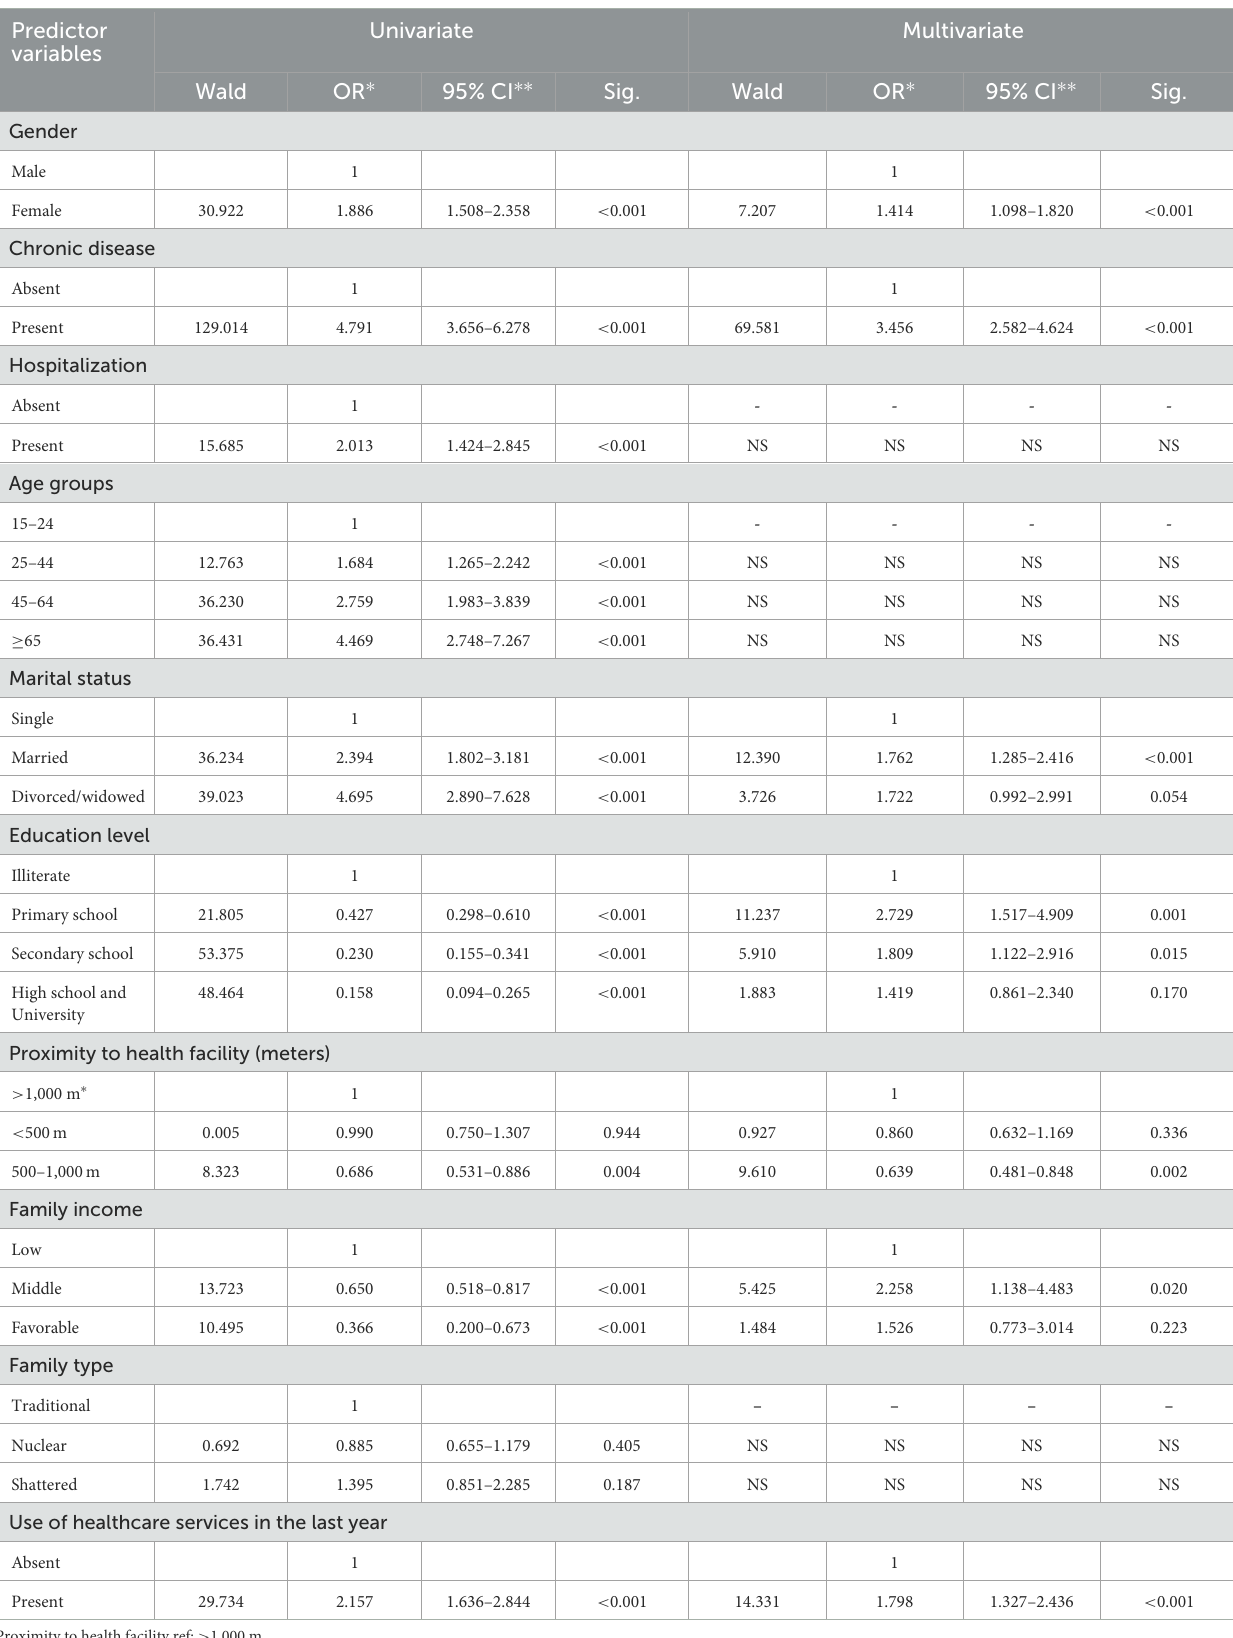
TABLE 6 Univariate and multiple logistic regression (Backward-Wald Method) analyses for models predicting poor self-rated health in 2004 ( n = 1,304). Predictor Univariate Multivariate variables Wald OR ∗ 95% CI ∗∗ Sig. Wald OR ∗ 95% CI ∗∗